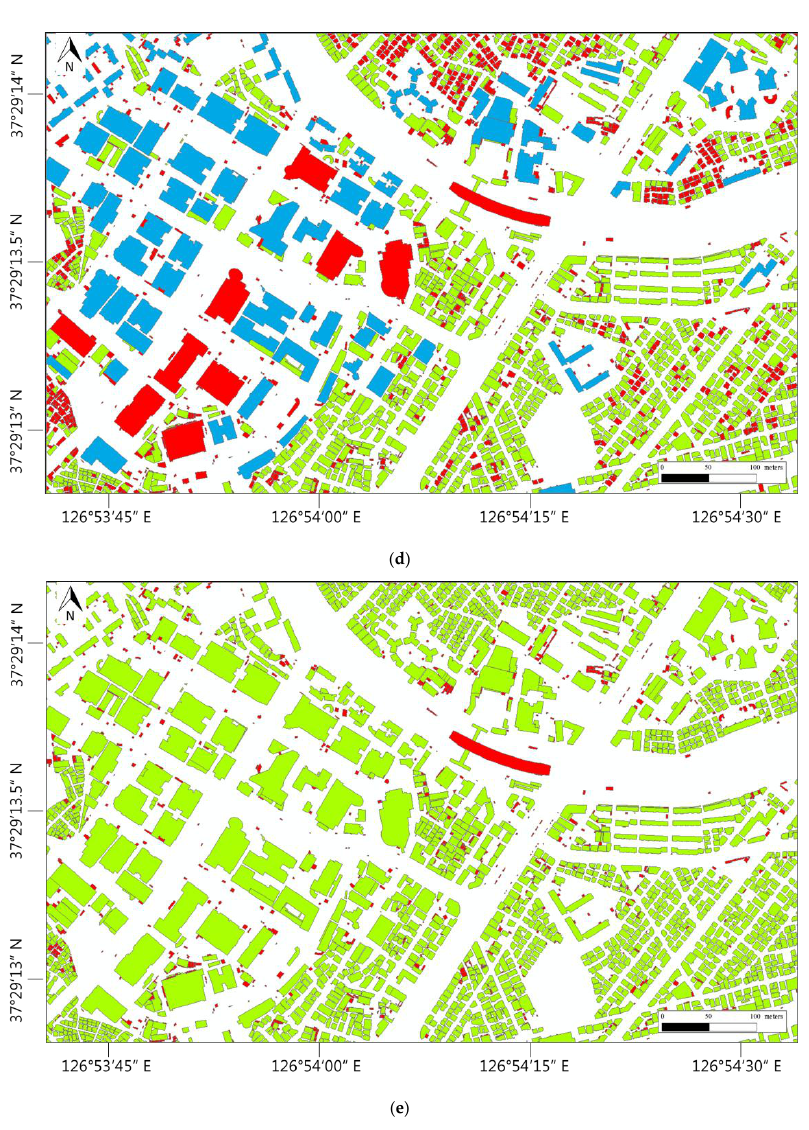
Figure 7. Visualized results of each algorithm: ( a ) original class, ( b ) DT, ( c ) k -NN, ( d ) NB, and ( e ) SVM. Blue = eliminated (0); green = retained (1); and red = aggregated (2).